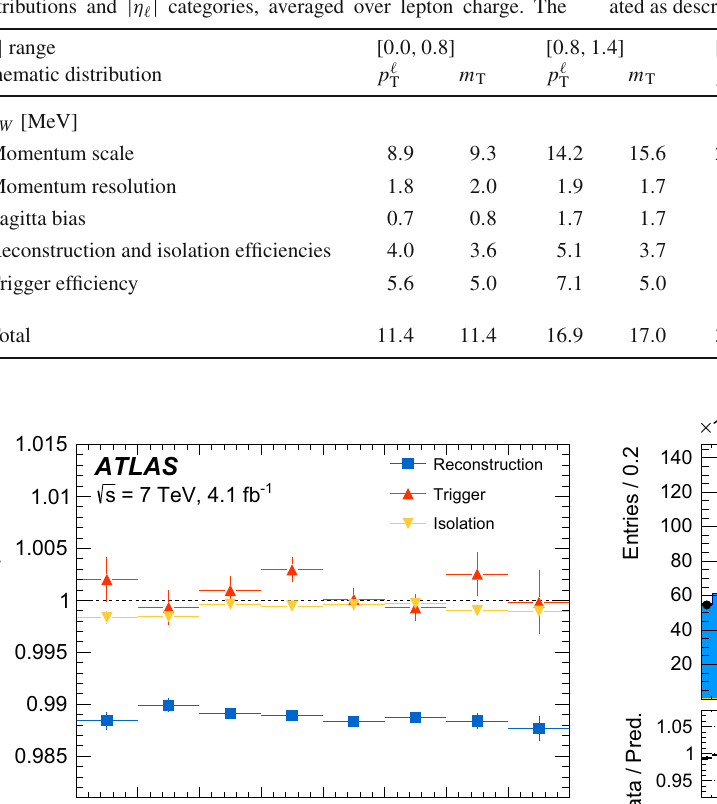
Table 4 Systematic uncertainties in the m W measurement from muon calibration and efficiency corrections, for the different kinematic distributions and | η (cid:7) | categories, averaged over lepton charge. The